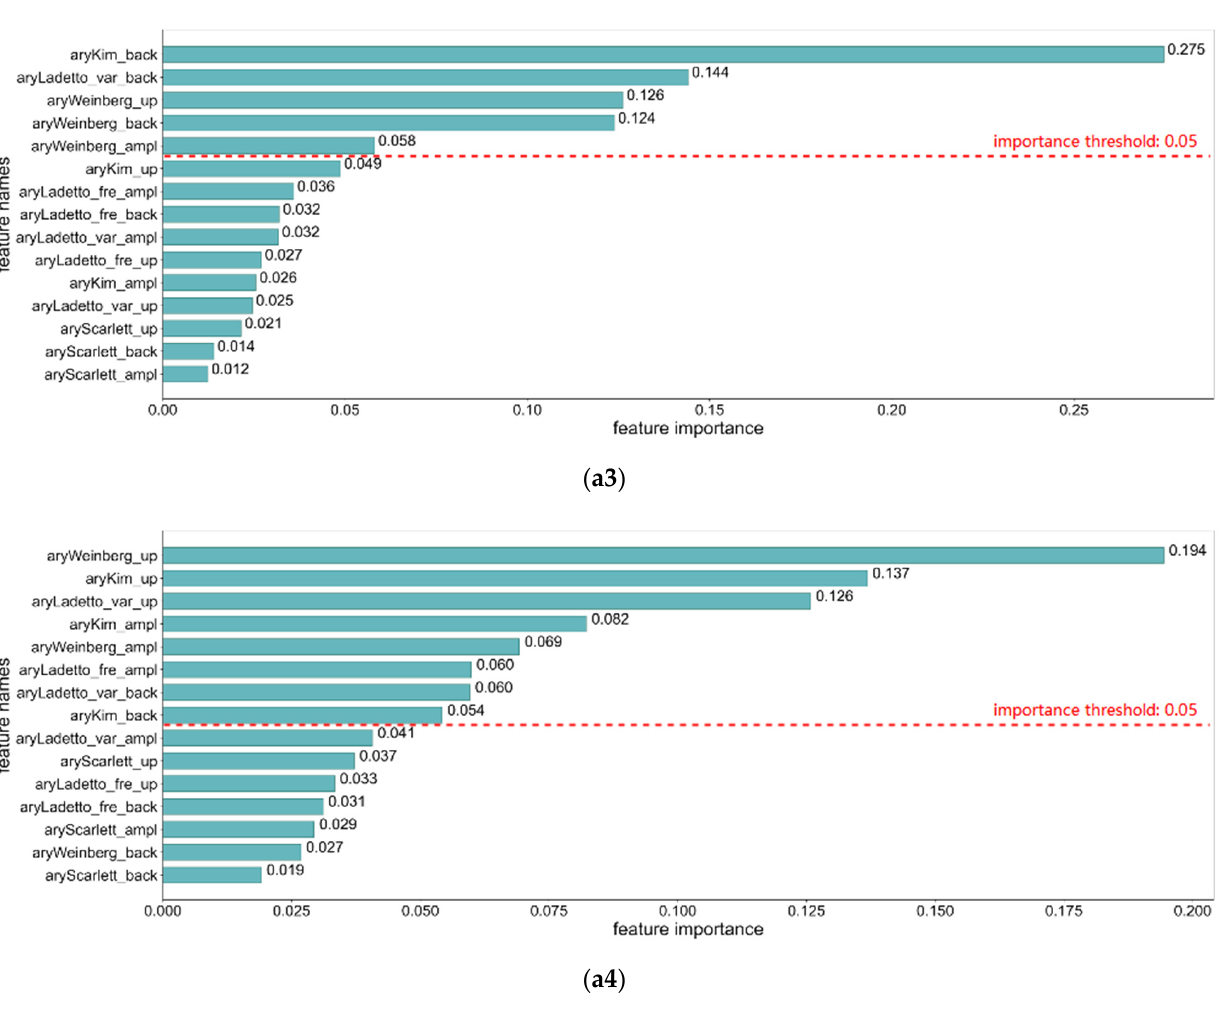
Figure 7. Feature importance rankings. ( a1 ) Features extracted from whole stride acceleration data; ( a2 ) Features extracted from push-off phase acceleration data; ( a3 ) Features extracted from swing phase acceleration data; ( a4 ) Features extracted from heel-strike phase acceleration data.